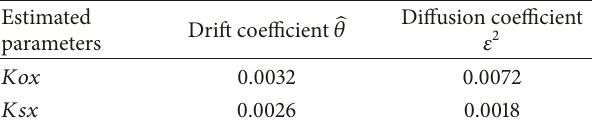
Table 1: The results of the estimated parameters. Estimated ̂𝜃 Diffusion coefficient Drift coefficient 𝜀 2 parameters 𝐾𝑜𝑥 0.0032 0.0072 𝐾𝑠𝑥 0.0026